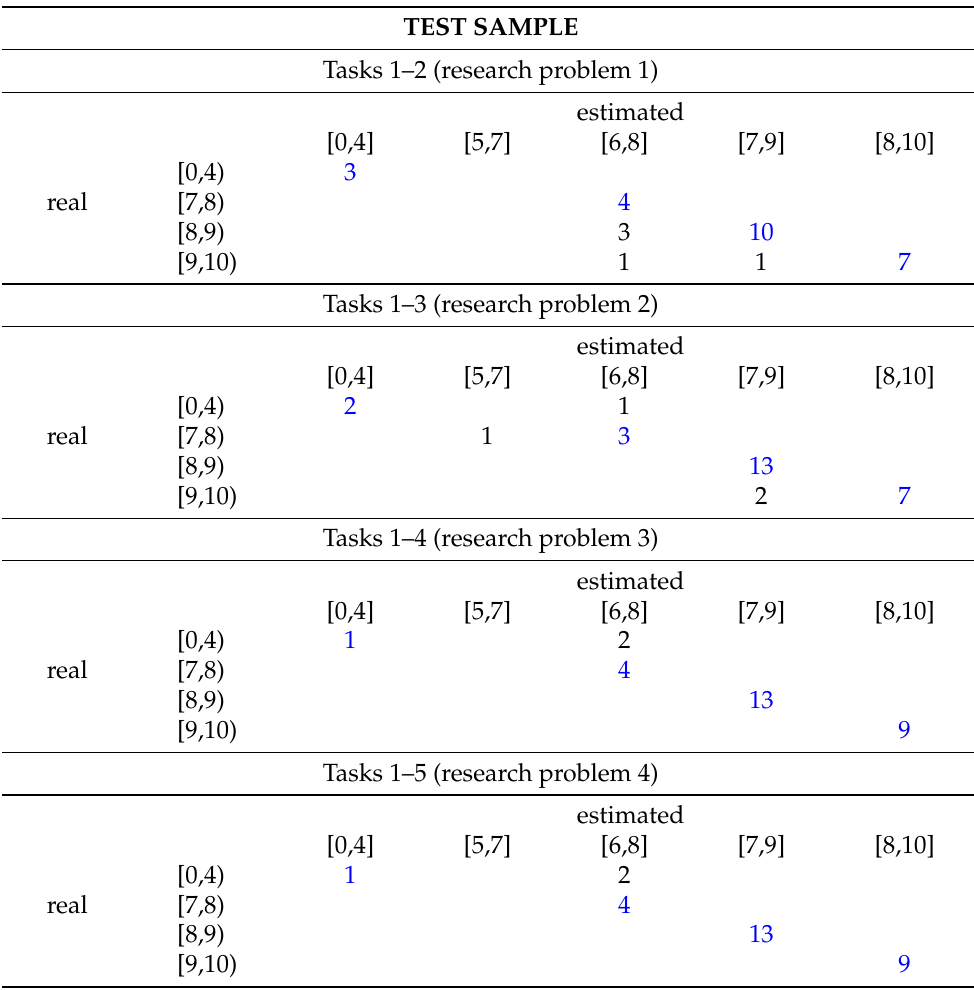
Table 1. Four confusion matrices between the real average grade intervals (columns) and the estimated average grade intervals (rows) for the n = 29 test data (academic course 2020/21) on the model constructed using the m = 50 training data (academic courses 2017/18, 2018/19, 2019/20). 3 test data belong to the interval [0,4), 4 to [7,8), 13 to [8,9), and 9 to [9,10) (intervals reported in (6)). The analysis is based on: Tasks 1 and 2 (top matrix), Tasks 1, 2 and 3 (second matrix from the top), Tasks 1, 2, 3, and 4 (third matrix from the top) and Tasks 1, 2, 3, 4, and 5 (bottom matrix). The average grades make use of the six Tasks. The groups of students whose average grade is clearly correctly classified are in blue. The omitted values correspond to